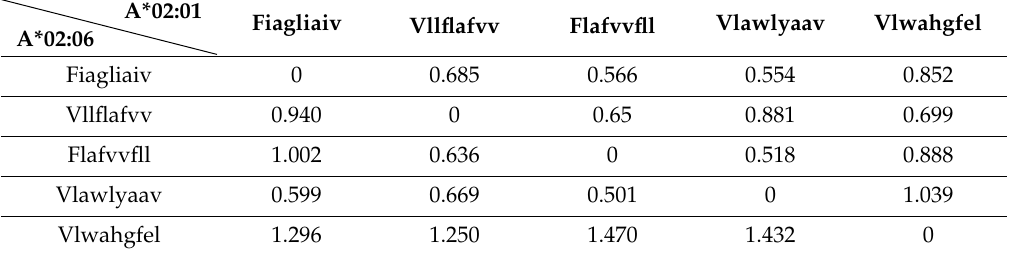
Table 6. Comparison of the C α atom positions of the five most immunogenic SARS-CoV-2 epitopes. Upper and lower triangular data show root–mean–square deviations in Ångströms for the epitopes in complex with HLA-A*02:01 and HLA-A*02:06,